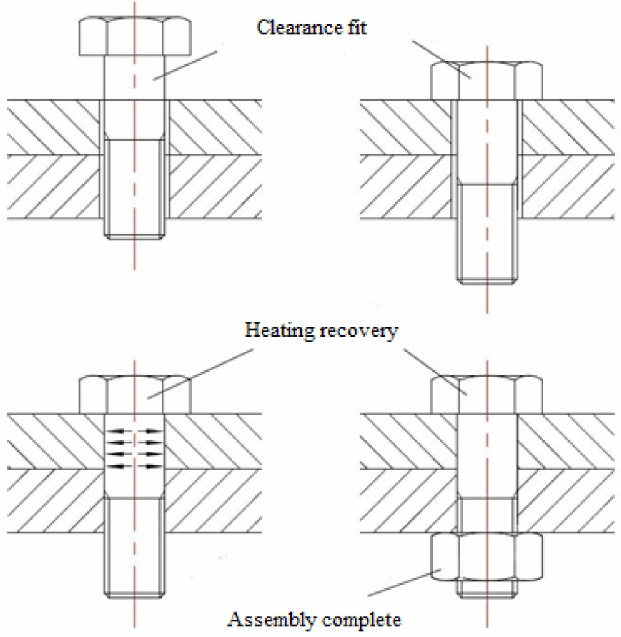
Figure 1. Installation principle of SMA interference